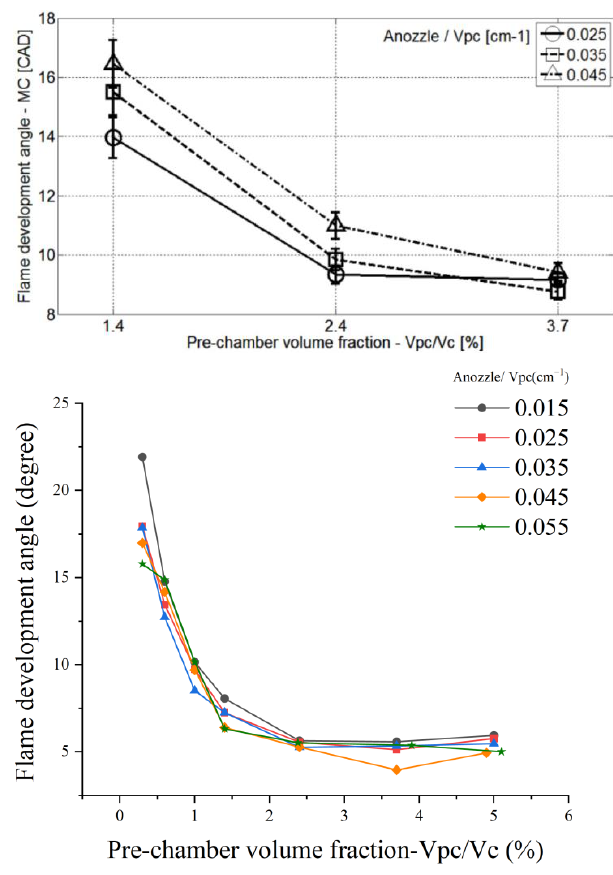
Figure 9. Simulation results of main chamber FDA vs. results from Ashish [24].